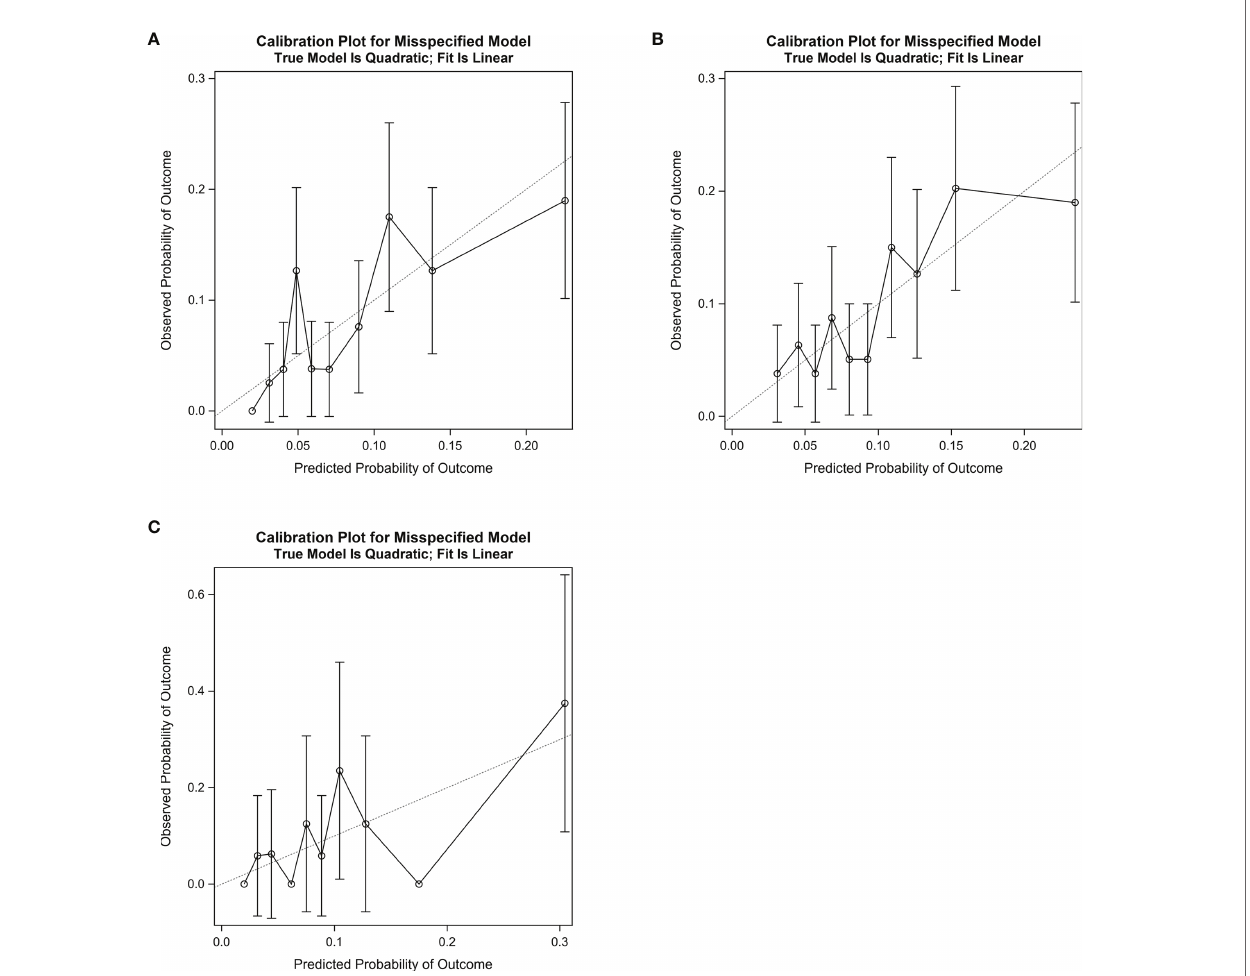
FIGURE 5 | Calibration slope for the algorithm in the training group (A) , the internal validation group (B) , and the external validation dataset (C) . In the curve, the decile ’ s observed probability of developing postoperative pneumonia was plotted against corresponding predicted probability of developing postoperative pneumonia. The dotted line indicates the ideal calibration slope (Slope = 1.00). The calibration slope was 0.88 (95% CI: 0.37 – 1.39) in the training group, 0.90 (95% CI: 0.46 – 1.34) in the internal validation group, and 1.03 (95% CI: 0.24-1.83) in the external validation dataset.